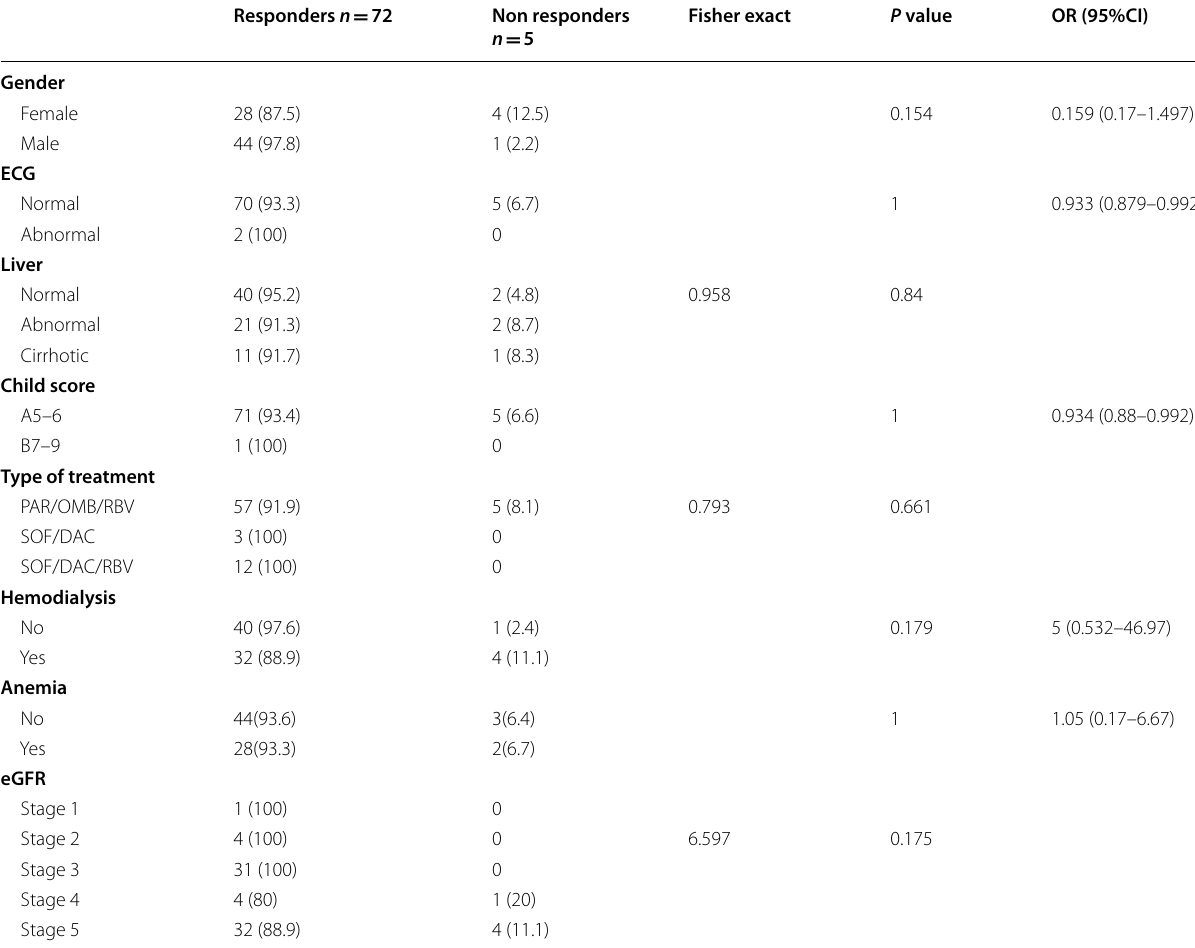
Table 4 Relation between response to treatment and the qualitative variables